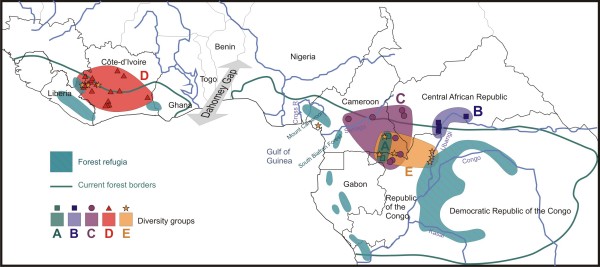
Geographic position of the five major C. canephora genetic subgroups. Geographic position of the five major C. canephora genetic subgroups collected together with a schematic map of forest refugia over the course of the last major arid phase (c. 18,000 years BP), adapted from Maley [2].